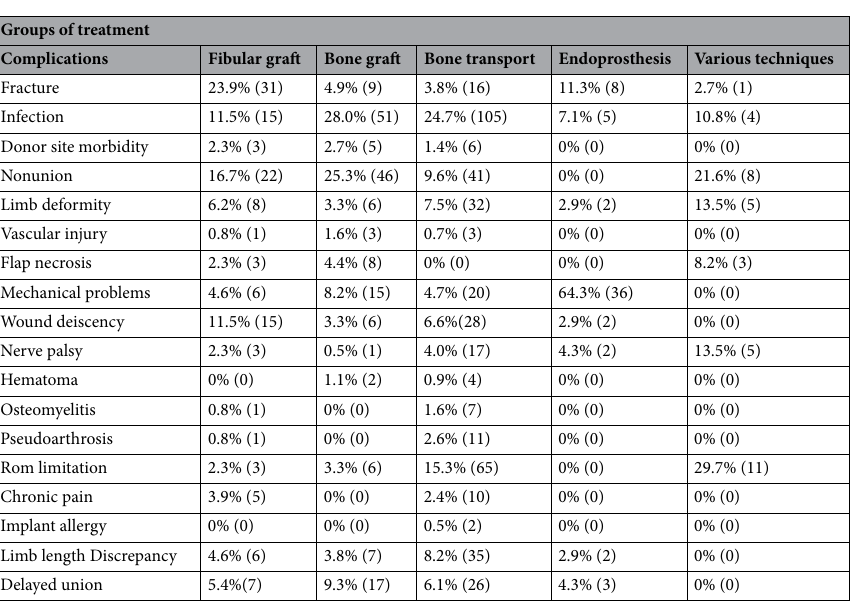
Table 6. Summary of all